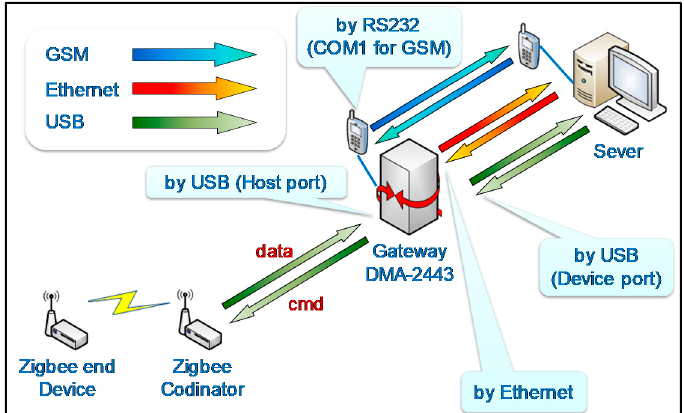
Figure 2. Operational schematic diagram.